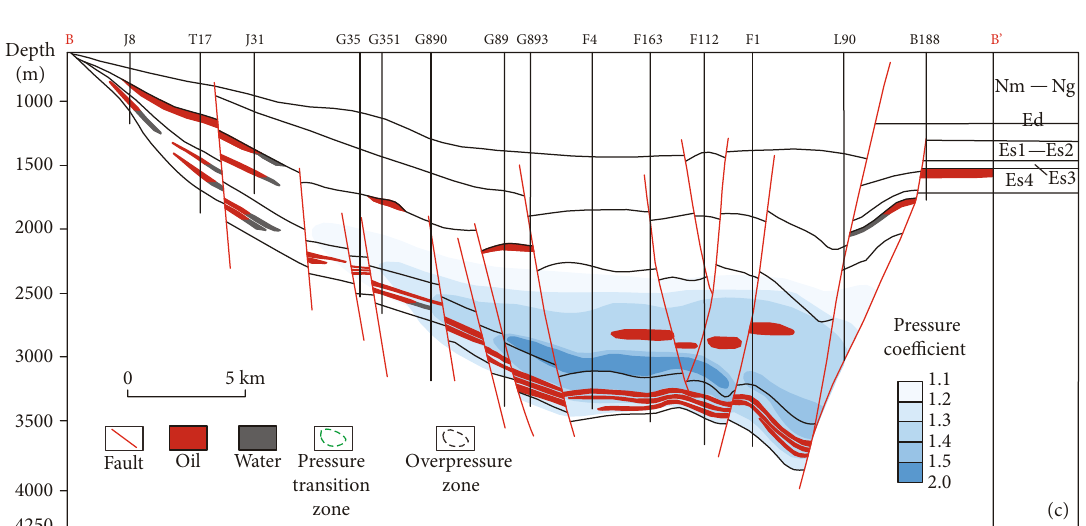
Figure 1: (a, b) Structural map of the Bohai Bay Basin and tectonic setting of the Dongying Depression. (c) Cross-section of B – B ’ in the Boxing Sag (modi fi ed from